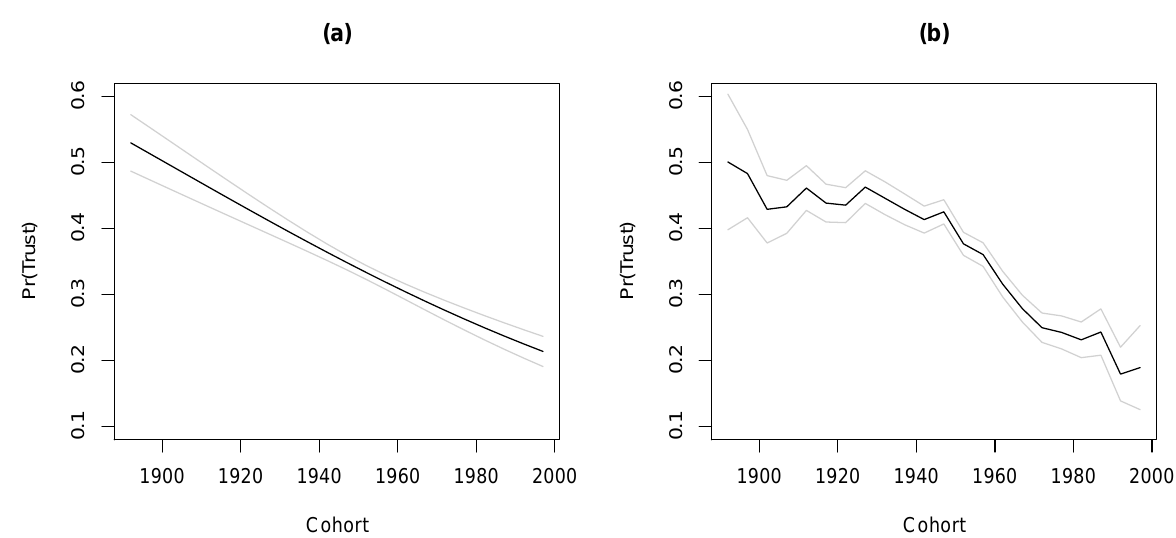
Figure 8: Diachronic cohort slope and curve. Notes: (a) displays the diachronic cohort slope, whereas (b) displays the diachronic cohort curve. Calculations are based on θ 2 ( k − k ∗ ) and θ 2 ( k − k ∗ ) + for k = 1, . . . , K . Parameter estimates are derived from a diachronic L-APC logistic regression model. Upper and lower bounds denote 95 percent confidence intervals. Outcome is social trust, coded so that 1 = “can trust” while 0 = “can’t be too careful” or “depends.” Results adjusted using sampling